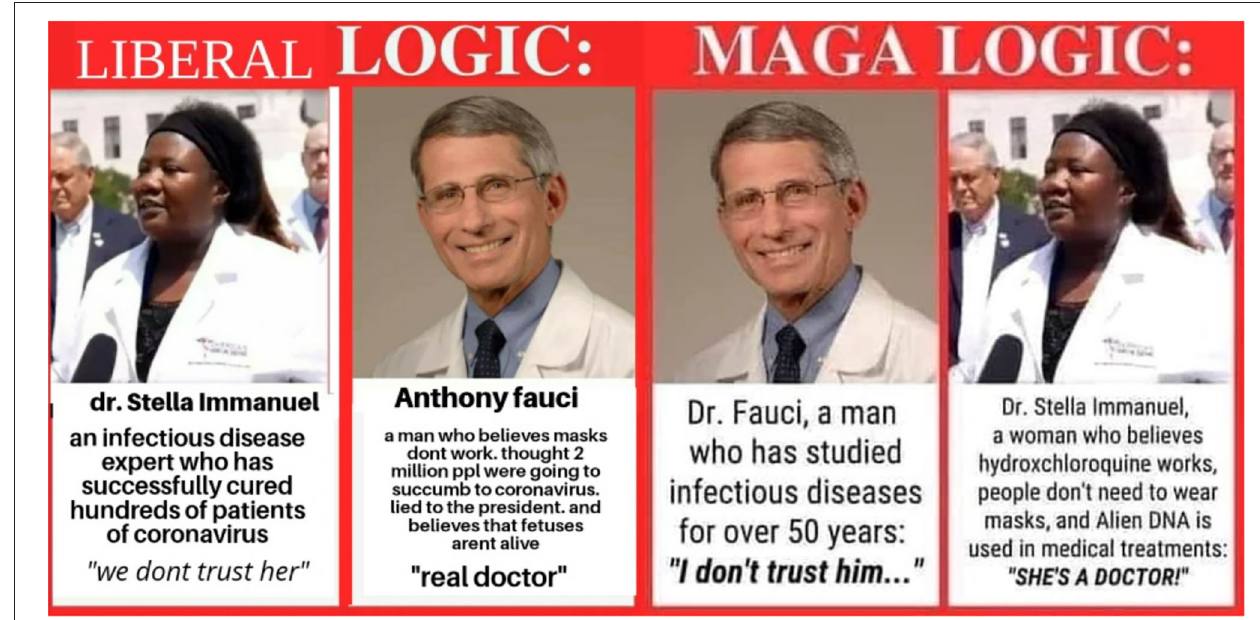
FIGURE 4 | Liberal Logic Meme (2020) vs. MAGA Logic Meme (2020).